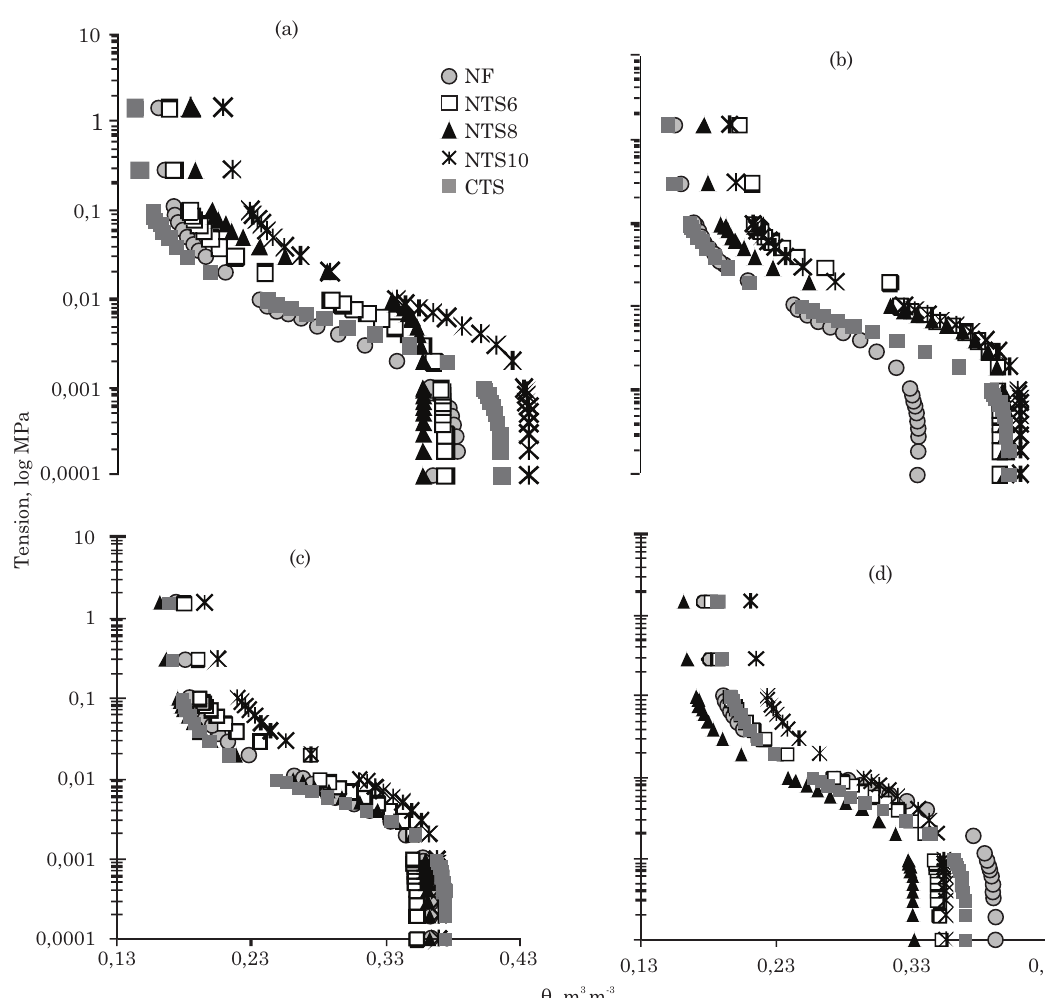
Figure 2. Water retention curves of a Red Oxisol in different layers. (a) 0-0.05 m, (b) 0.05-0.10 m, (c) 0.10-0.20 m and (d) 0.20-0.30 m. 2009/10 growing season – NF: native forest, NTS6: six-year no-tillage, NTS8: eight- year no-tillage, NTS10: ten-year no-tillage, and CTS: conventional tillage